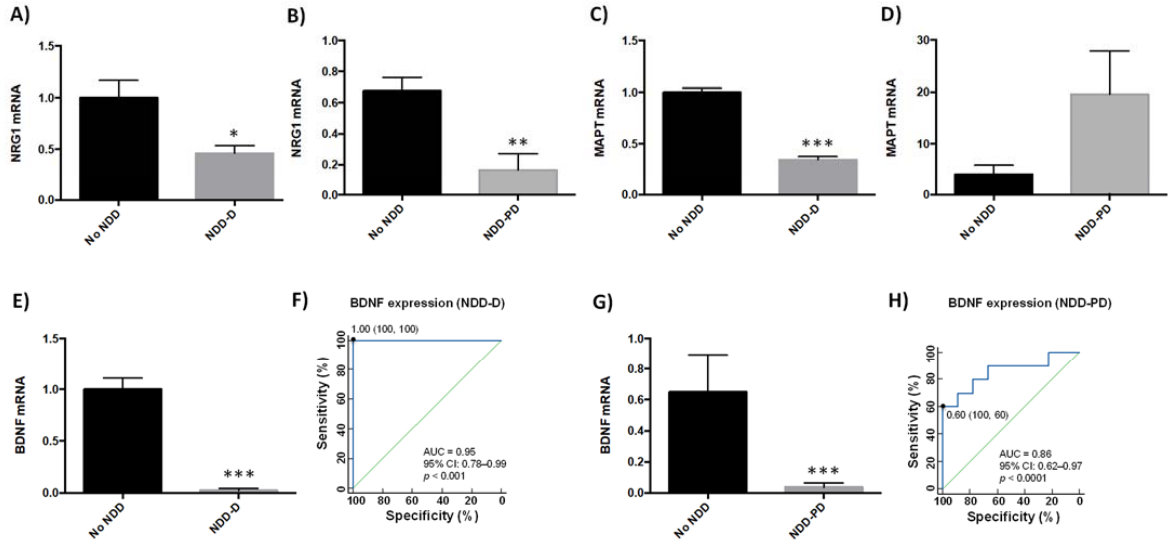
Figure 3. Gene expression in buffy coat samples from healthy individuals and patients with NDDs. qPCR was performed in samples from patients from the no-NDD ( n = 9), NDD-D ( n = 6) and NDD-PD ( n = 9) groups with TaqMan probes for NRG1 ( A , B ), MAPT ( C , D ) and BDNF ( E , G ); unpaired t tests (* p < 0.05; ** p < 0.01; *** p < 0.001). Data are presented as the mean ± S.E.M. ( F ) ROC curve, generated from BDNF mRNA expression data in patients with dementia, shows an AUC value of 0.95 (95% CI: 0.78–0.99), p < 0.0001. The optimal cutoff value determined by the Youden’s index was 1.00 (specificity: 100%, sensitivity: 100%) (black filled circle). The diagonal green line is the ROC curve reference line. ( H ) ROC curves for patients with parkinsonisms revealed an AUC for BDNF of 0.875 (95% CI: 0.62–0.97), p < 0.0001. The optimal cutoff value according to the Youden’s index was 0.60 (specificity: 100%, sensitivity: 60%) (black filled circle). AUC, area under the curve; BDNF, brain-derived neurotrophic factor; CI, confidence interval; MAPT, microtubule-associated protein tau; no-NDD, individuals with no neurodegenerative diseases; NDD-D, NDD patients with dementia; NDD-PD, patients with parkinsonisms representing PD and PD-like disorders; NRG1, neuregulin 1; PD, Parkinson’s disease; qPCR, quantitative real-time PCR; ROC 5, receiver operating characteristic